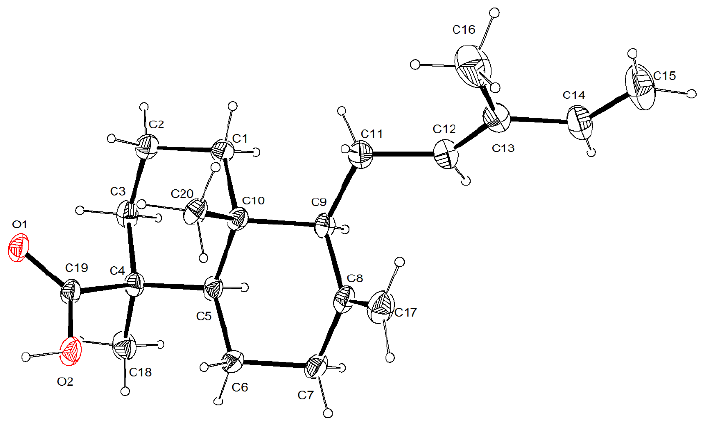
Figure 6. PLUTO plots of the single crystal X-ray diffraction structures of trans -communic acid ( 3 ).